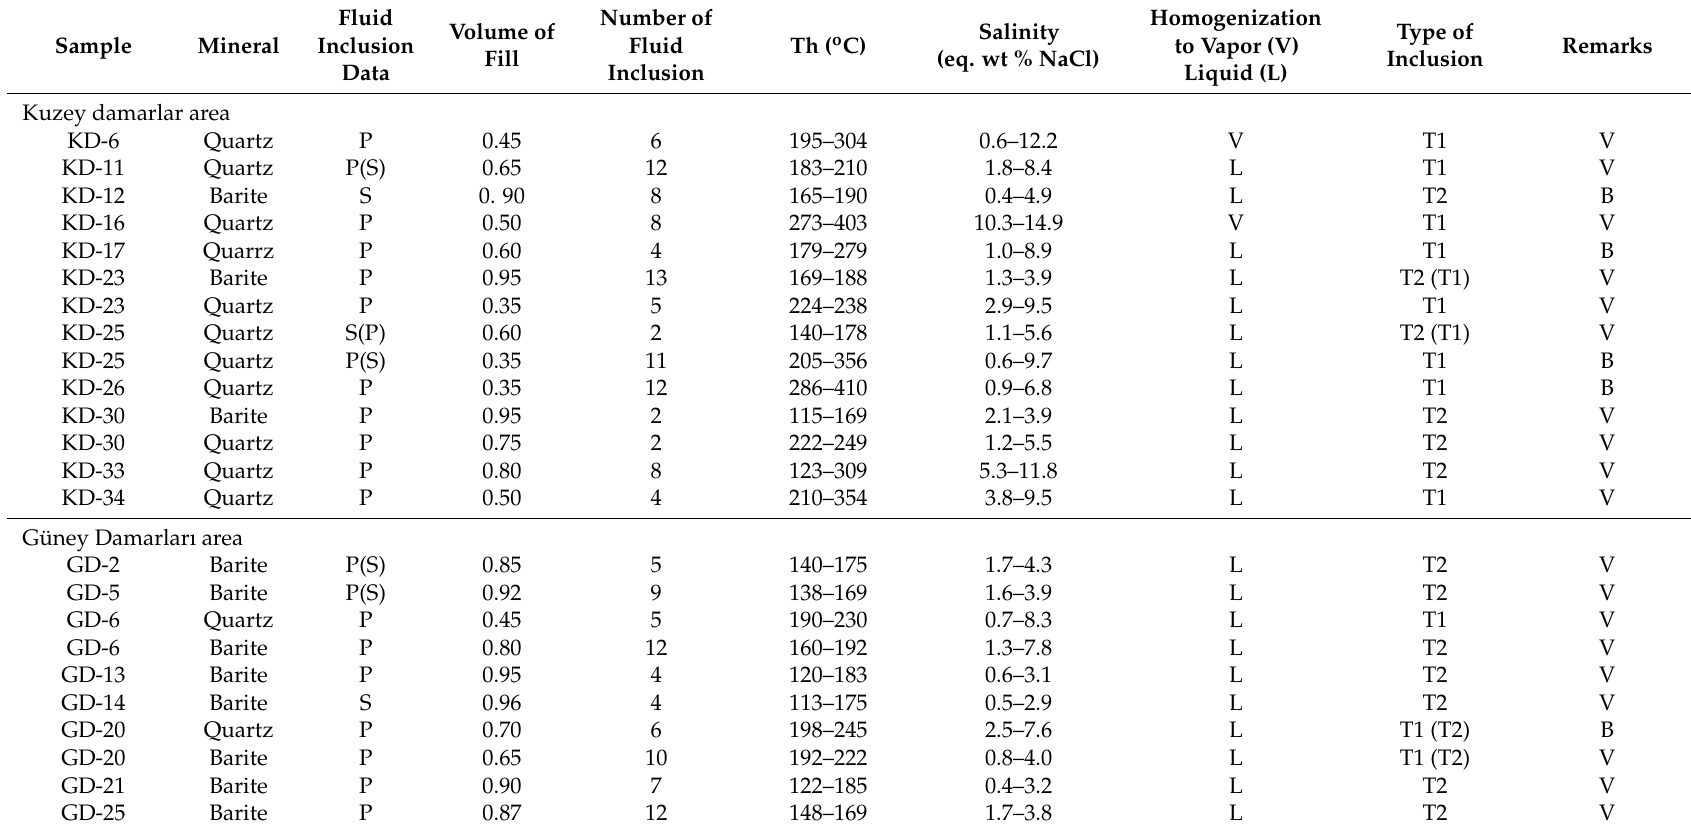
Table 4. Fluid inclusion data from Tumanpınarı Fe-Mn-Ba